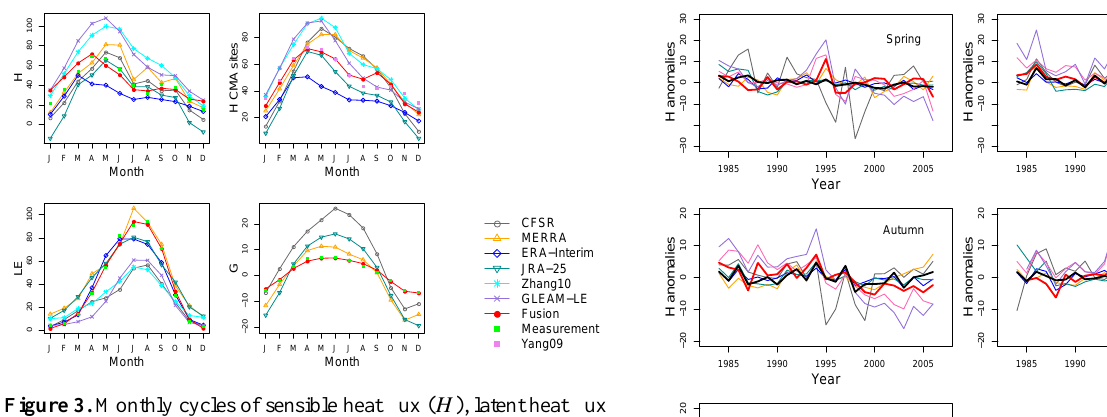
Figure 3. Monthly cycles of sensible heat flux ( H ), latent heat flux (LE), and ground heat flux ( G ) from multiple data sets and fused data with ground measurement averaged for all available sites (units are Wm − 2 ).